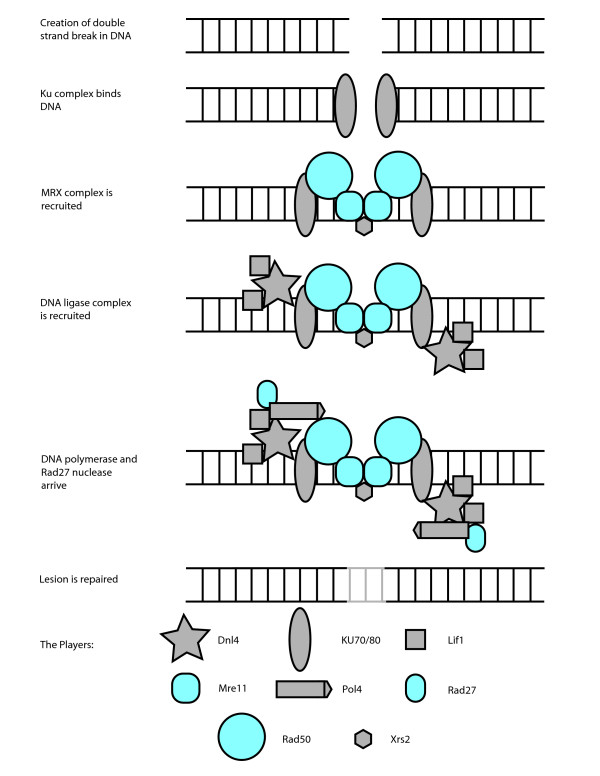
The non-homologous end joining repair pathway. (See text for explanation.) Blue proteins are present in E. cuniculi; all others are absent. Newly synthesized DNA is indicated in grey. (Modified from Hefferin and Tomkinson [32].)